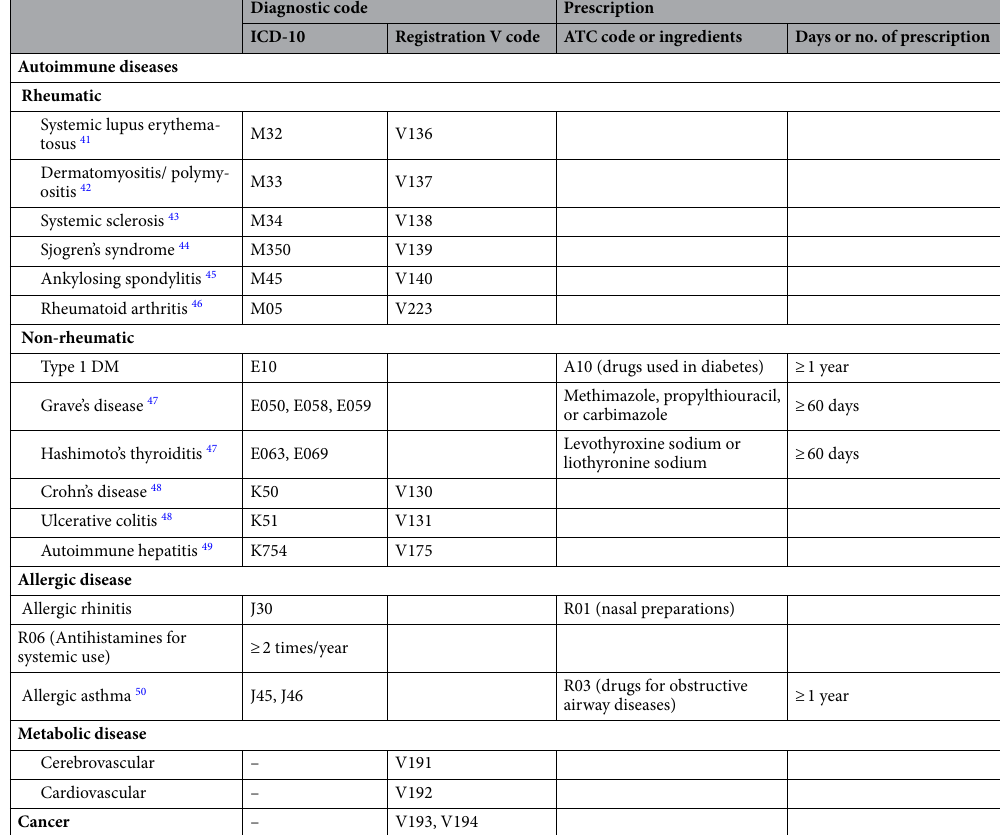
Table 1. Diagnostic criteria. ATC, Anatomical Therapeutic Chemical; DM, diabetes